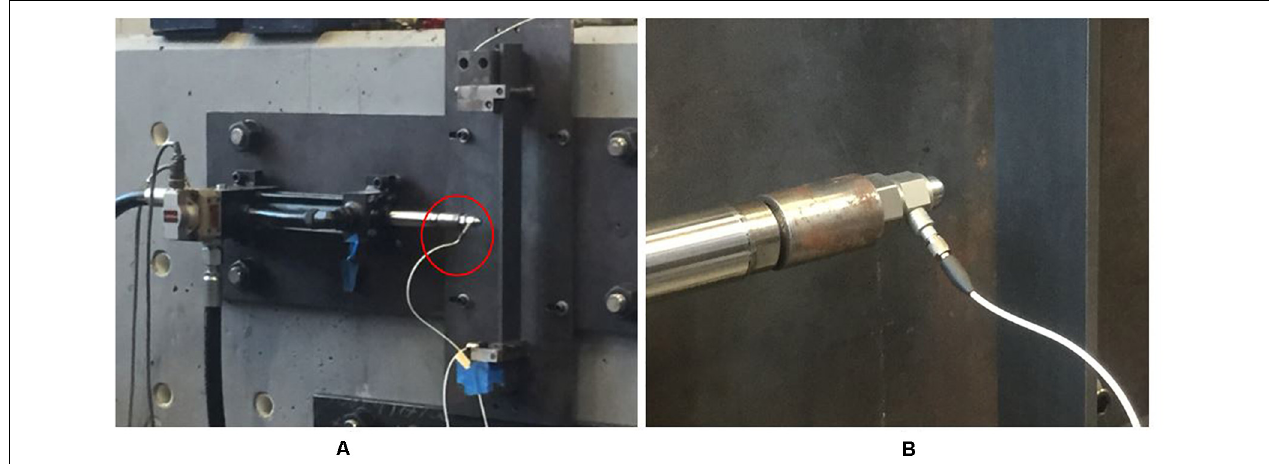
FIGURE 2 | (A) The hydraulic actuator with the force sensor circled and (B) a close-up view of the force sensor mounted on the actuator